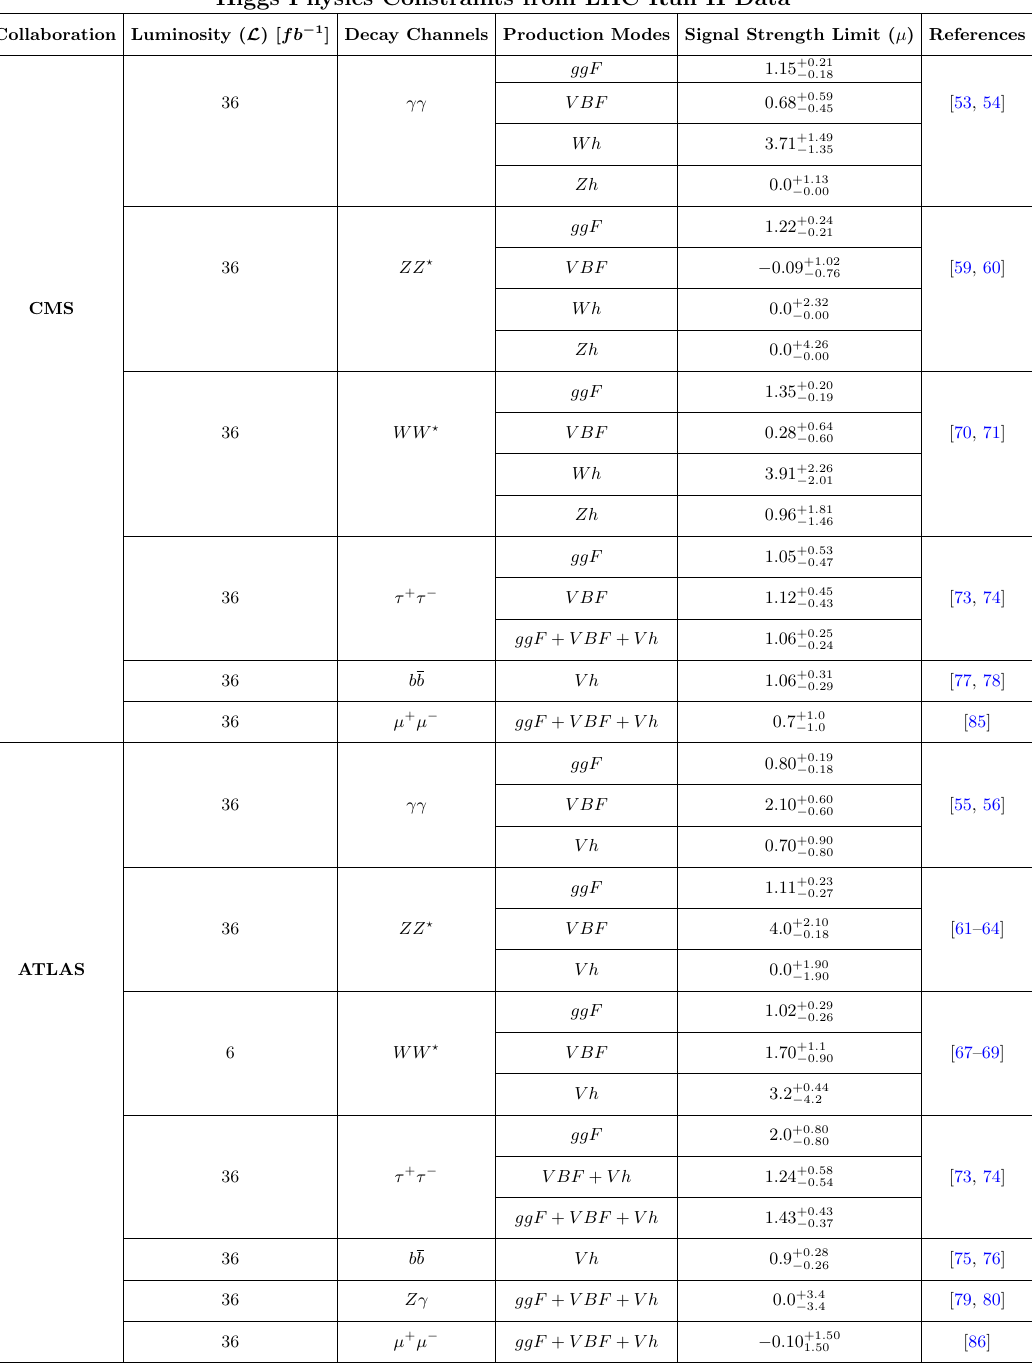
Table 3 . Signal strength constraints from recently reported 13 TeV LHC data along with